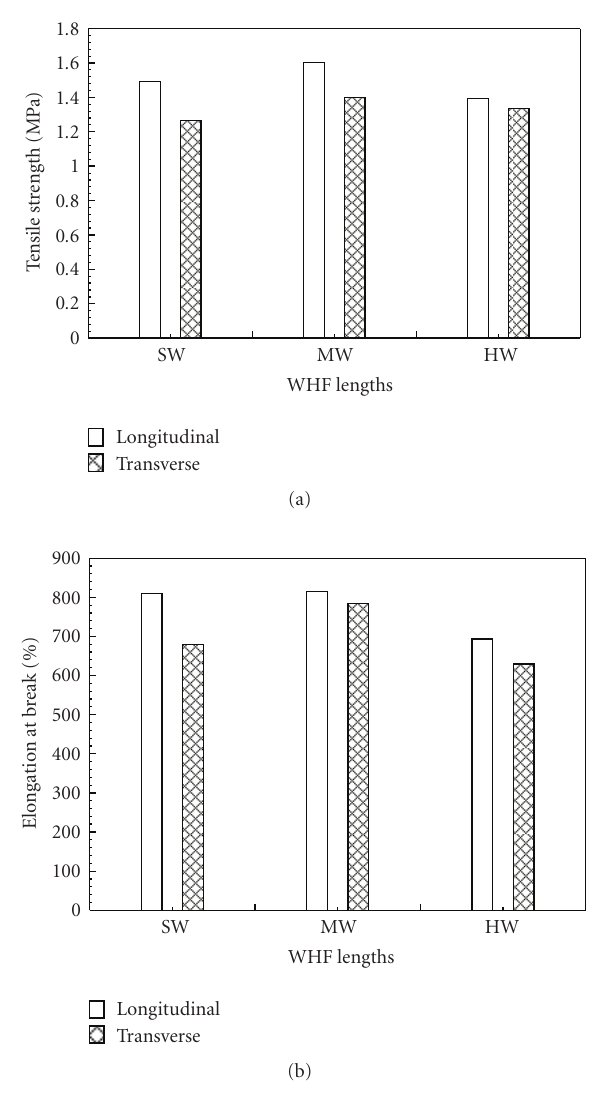
Figure 1: (a) Tensile strength and (b) elongation at Break,%, of wheat husk fibers-(WHFs) filled EPDM mixtures at di ff erent